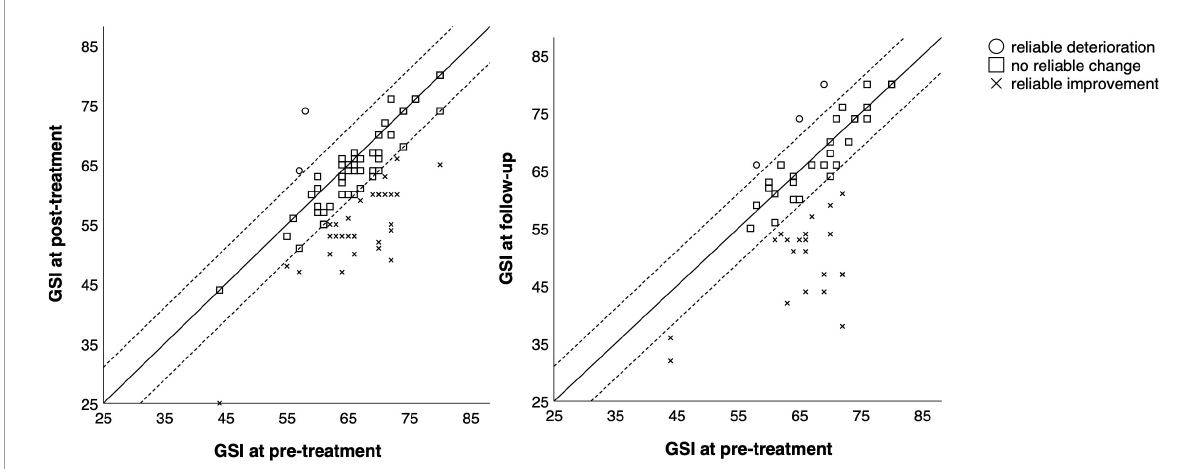
FIGURE3 Comparison of pre-treatment, post-treatment, and follow-up scores in the GSI-scale for each participant. Reliable change index was calculated according to Jacobson and Truax (24).